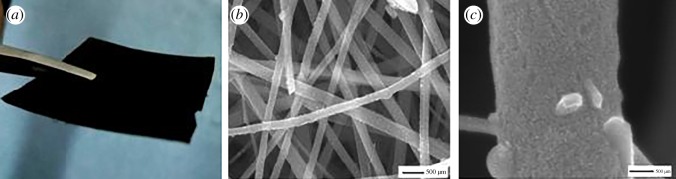
Optical and SEM images of nano-TiO2/C fibre membrane under different magnifications.